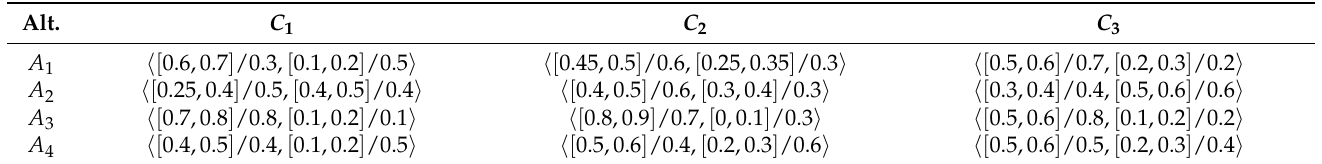
Table 5. Decision matrix R 2 provided by expert e 2 .